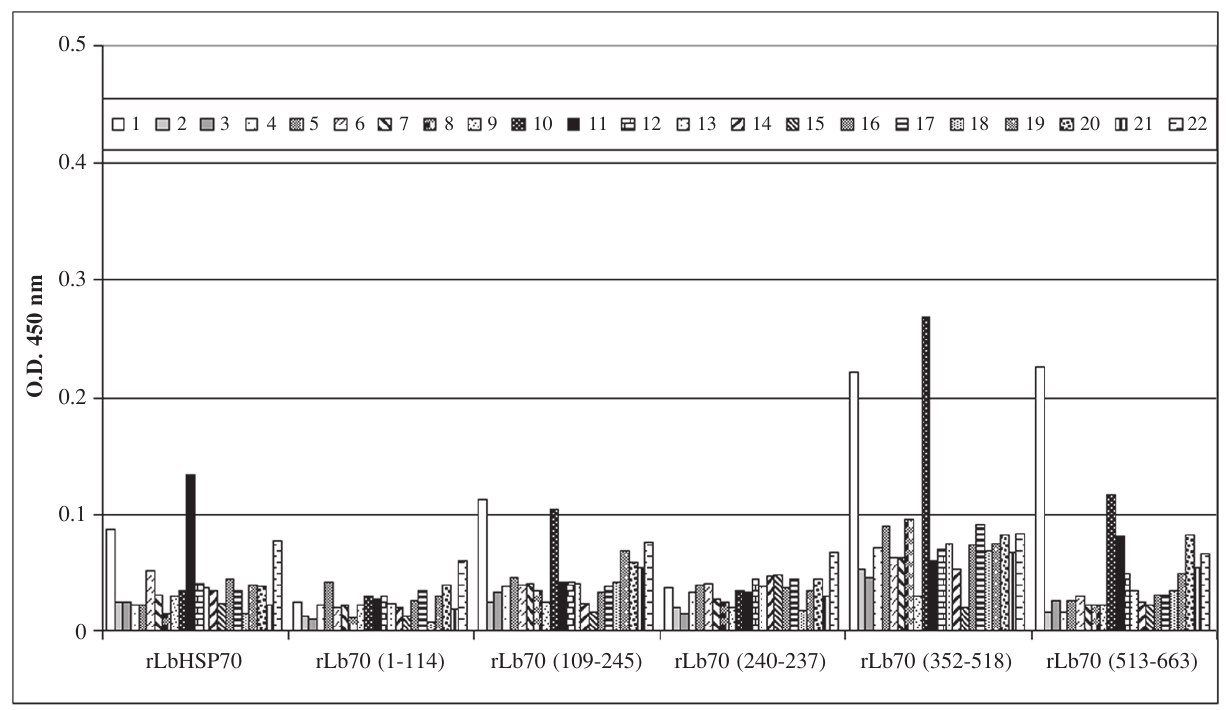
Fig. 1. – The graph shows the reactivity, assayed by ELISA, of the 22 sera from autoimmune-disease sufferers against the full-length Hsp70 and its fragments. The cut-off value was defined as the mean absorbance value of the control sera + 3 standard deviations (SD). Since this value was always below 0.1, it was established at 0.1. The legend in the graph shows the pattern assigned to each sera, numbered 1 to 22 for